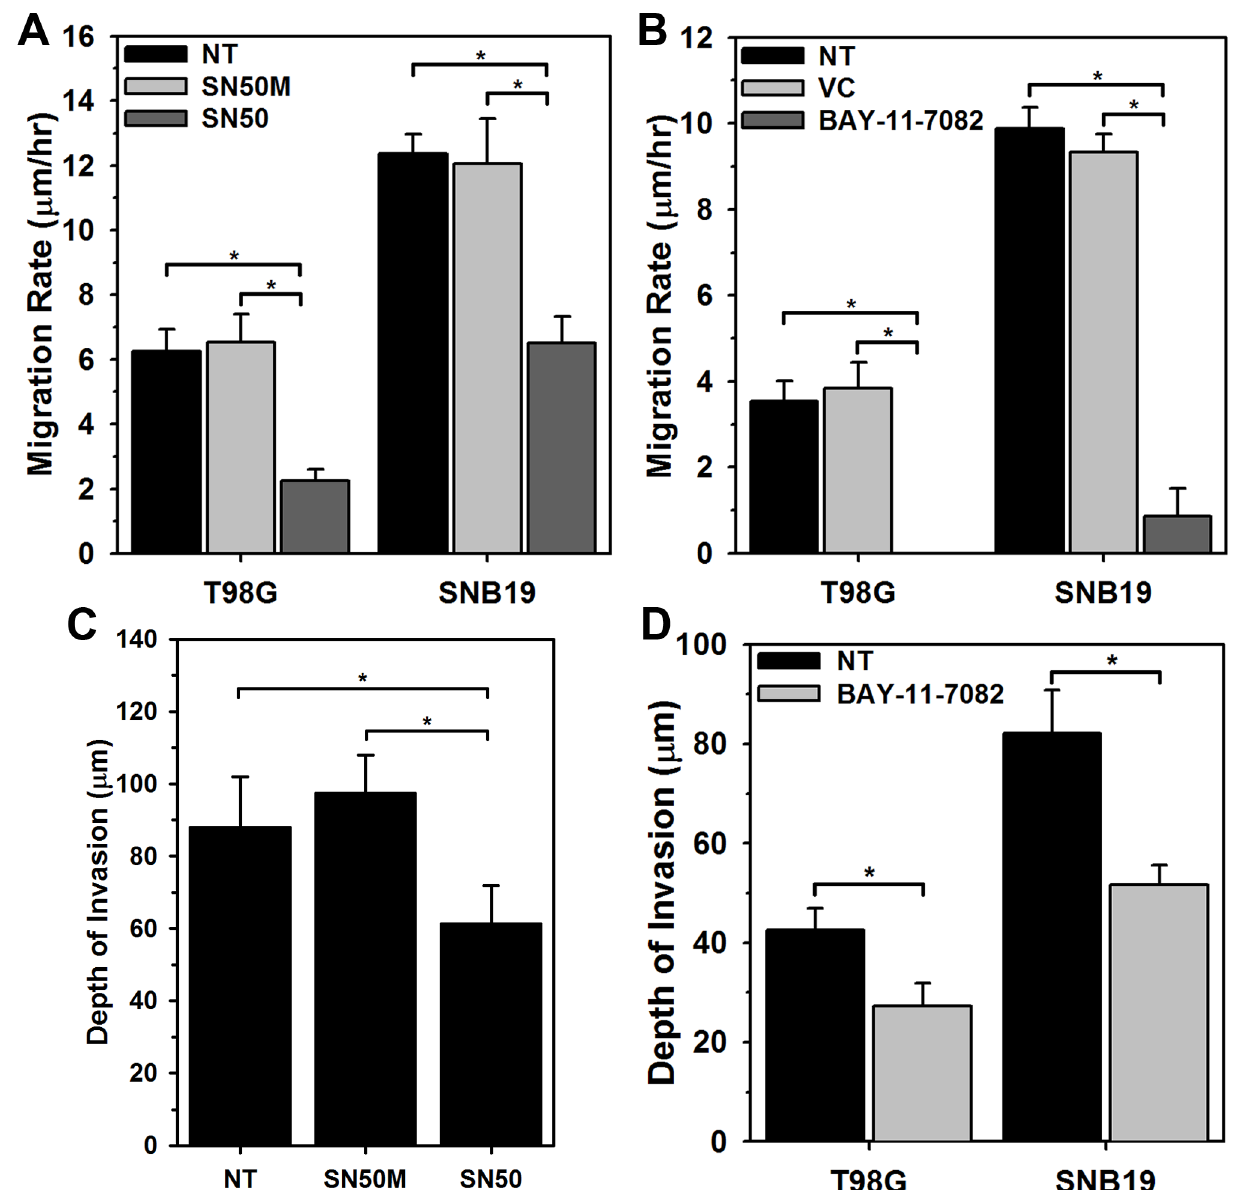
Figure 8. Inhibition of NF- k B function suppresses glioma cell migration in vitro and invasion ex vivo. Treatment with 50 m M SN50 peptide inhibitor suppresses migration of (A) T98G and SNB19 glioma cells in a radial migration assay when compared with untreated (NT) or scrambled peptide treated (SN50M) cells (*; p , 0.0001). (B) SNB19 glioma cells stably expressing GFP were implanted into the bilateral putamen on rat organotypic brain slices. Implanted cells were then treated with SN50 peptide inhibitor, scrambled peptide (SN50M) or left untreated (NT) and observed at 48 hrs. Depth of invasion was then calculated from Z-axis images collected by confocal laser scanning microscopy. The mean value of the depth of invasion was obtained from four independent experiments (*; p , 0.0001). Treatment with 20 m M NF- k B functional inhibitor (BAY-11-7082) suppresses migration of (C) T98G and SNB19 glioma cells in a radial migration assay when compared with untreated (NT) or DMSO treated (VC) cells (*; p , 0.0001). (D) Similar ex vivo brain slice invasion assay as described in B with NF- k B functional inhibitor (BAY-11-7082) demonstrated reduced invasion of T98G and SNB19 glioma cells. The mean value of the depth of invasion was obtained from four independent experiments (*; p , 0.0001). doi:10.1371/journal.pone.0072134.g008 are two associated but dichotomous processes. This contradictory compelling evidence that transcription factor NF- k B aids in cell behavior may be attributed to the disappearance of cell expression of genes involved in cell survival, invasion/metastases, survival signals associated with NF- k B or sustained signaling from and inflammation [49]. And as expected when NF- k B function other transcription factors including AP2, GATA or JAK/STAT was inhibited using the pharmacological inhibitor BAY-11-7082, proteins. Recently, Zanotto-Filho et al demonstrated that phar- glioma cells demonstrated reduced migration and invasion macological inhibition of NF- k B using a variety of different small (Figure 8). However, reduction in migration was accompanied molecule inhibitors and down-regulation of NF- k B using siRNA by reduced or unchanged rates of proliferation (Figure S7), which leads to cell apoptosis [50]. Romashkova and co-workers have deviates from the hypothesis that cell proliferation and migration